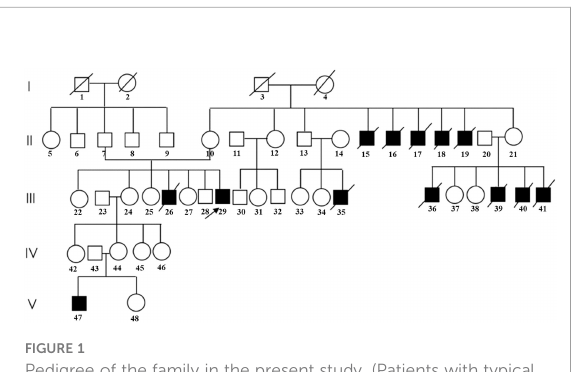
FIGURE 1 Pedigree of the family in the present study. (Patients with typical clinical symptoms of AHC are shown by darkened symbols. The black arrow indicates the